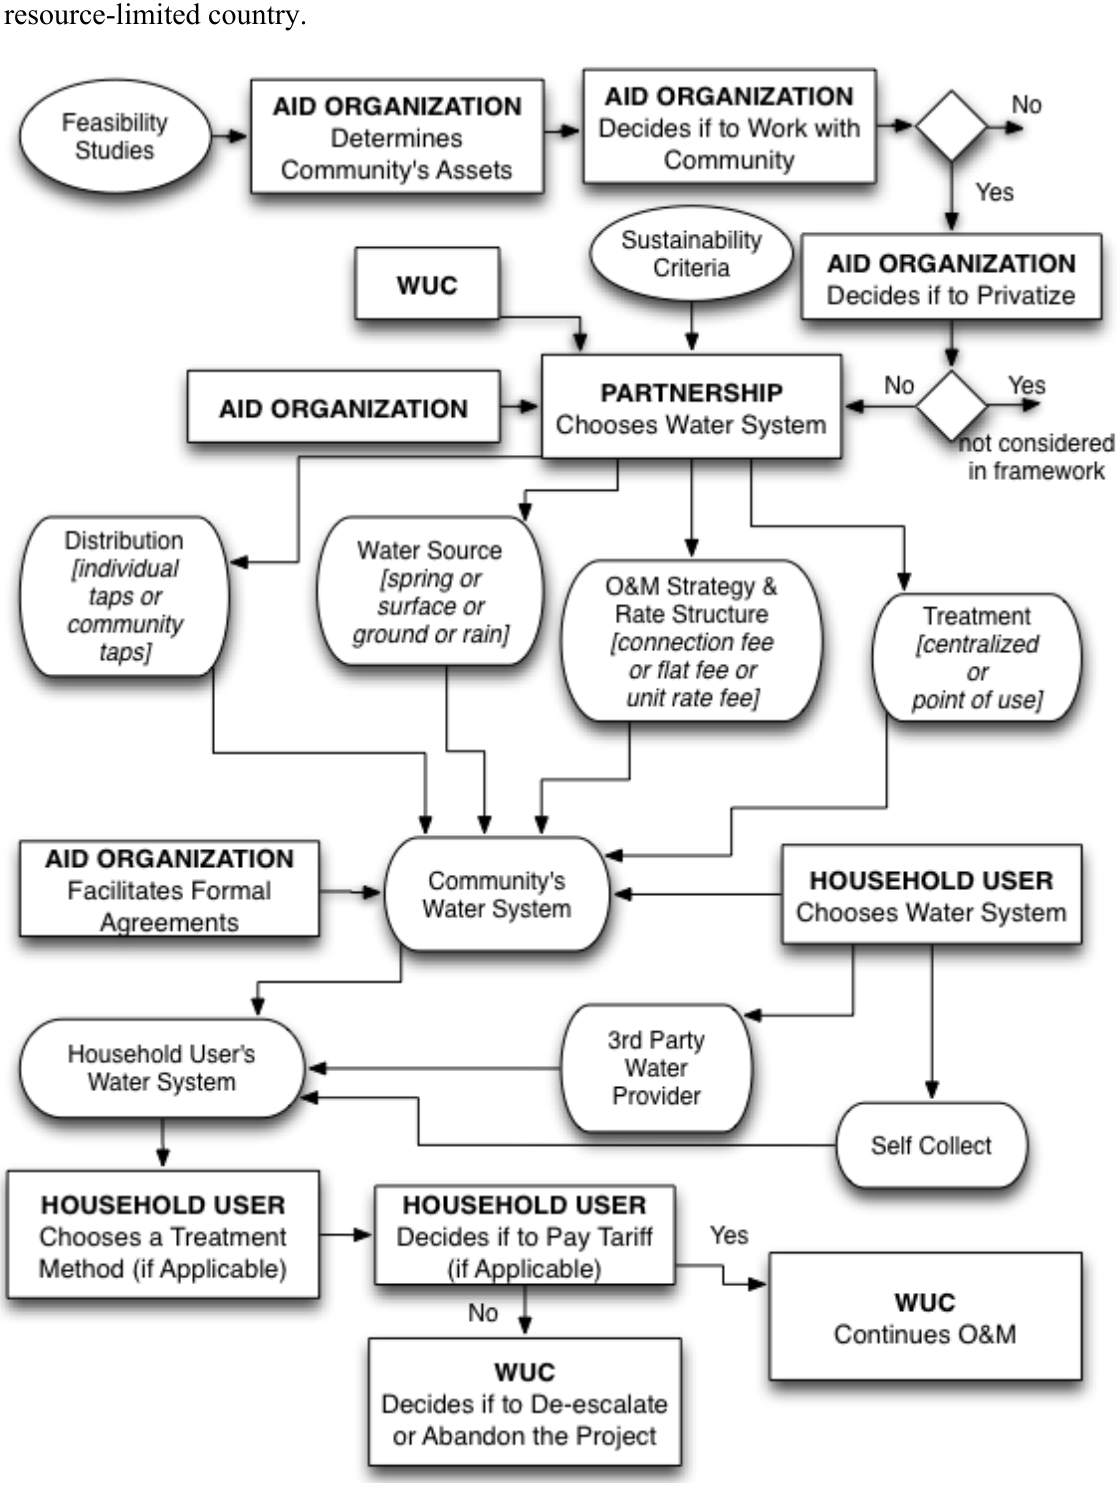
Figure 1. Overview of the decision process for the life cycle of a rural water system in a resource-limited